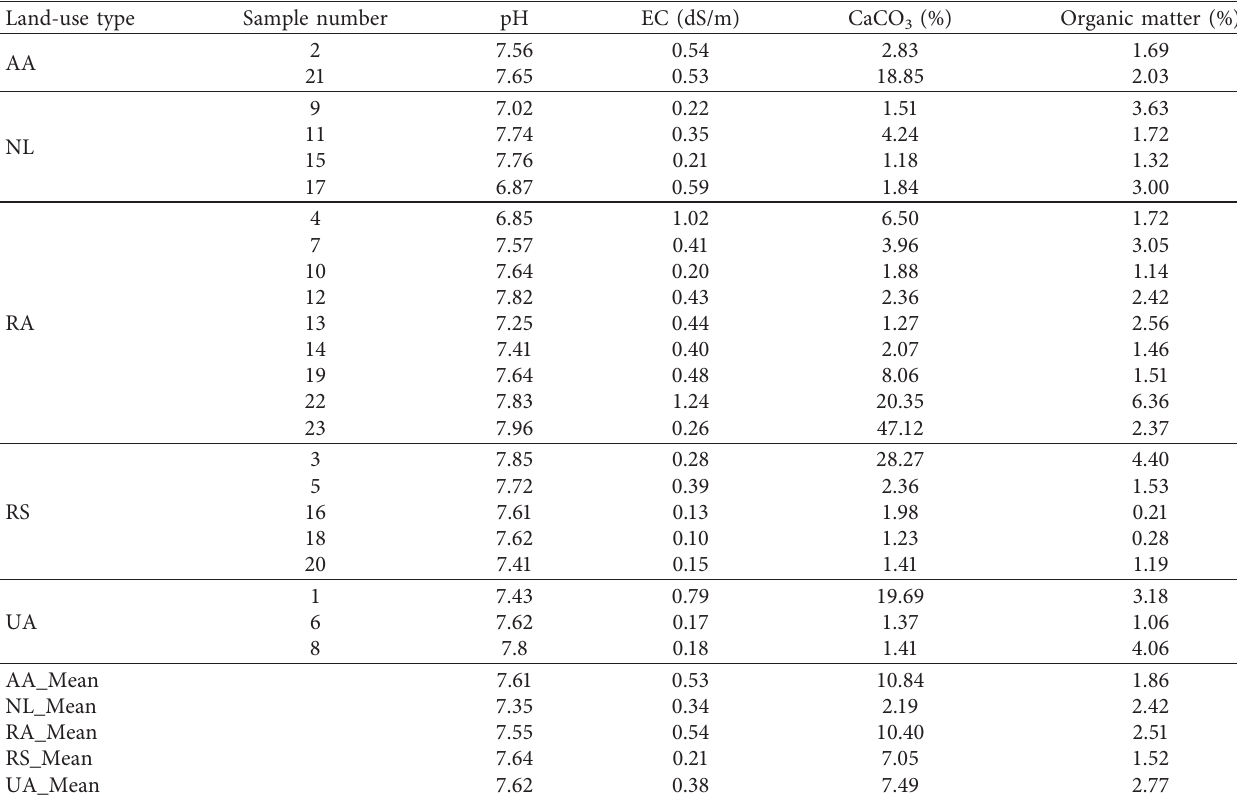
Table 2: The physical and chemical analyses of soil